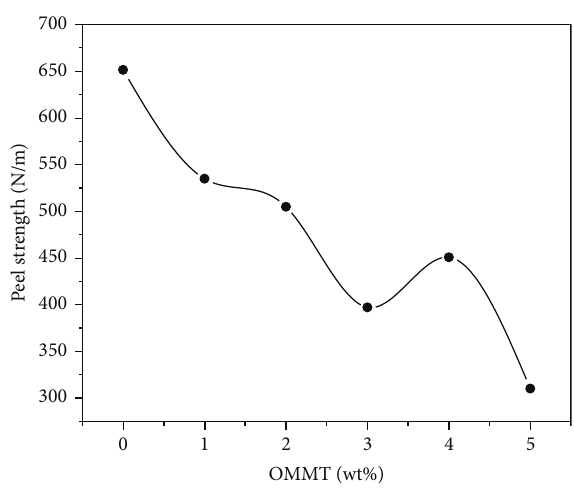
Figure 4: XRD patterns of MMT.